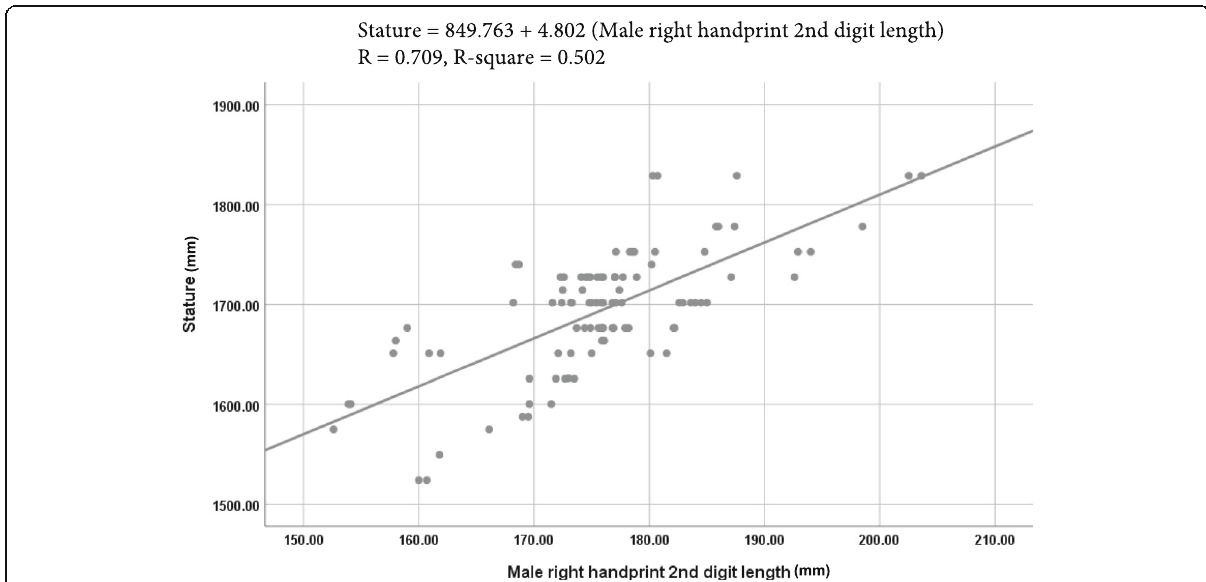
Fig. 3 Best fit curve to estimate stature from male right handprint 2 nd digit length